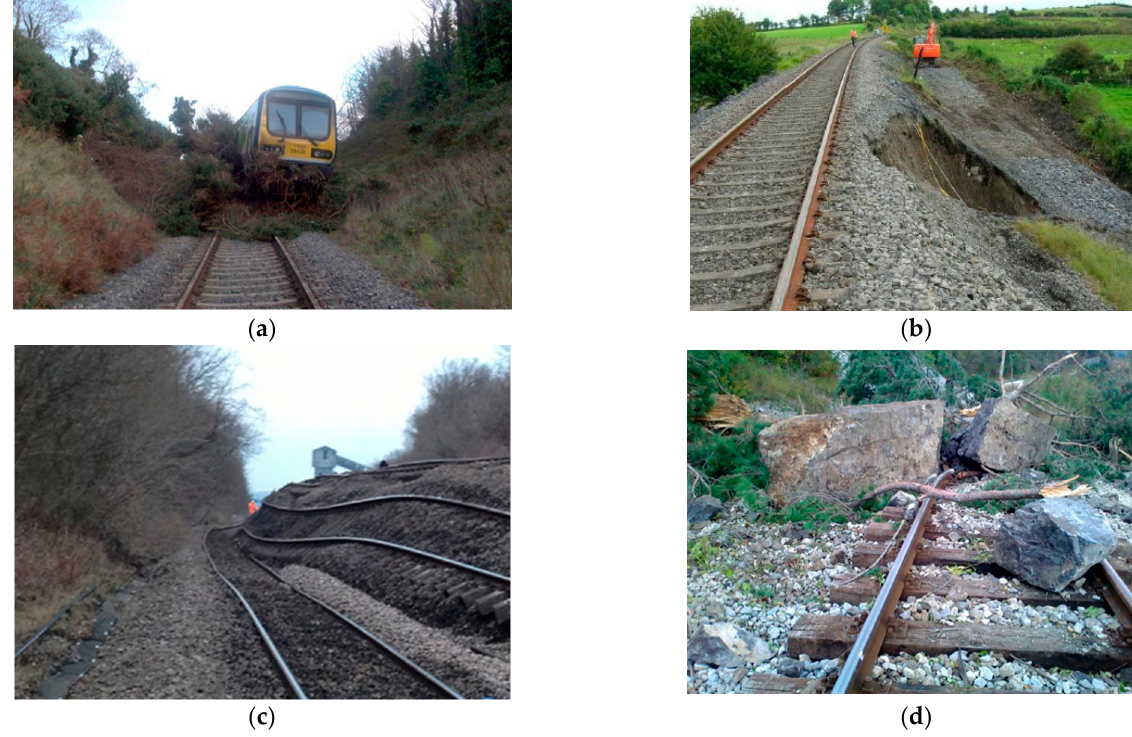
Figure 1. Examples of earthworks failures: ( a ) shallow translational failure in soil cutting, ( b ) shallow translational failure in an embankment, ( c ) deep rotational failure and, ( d )